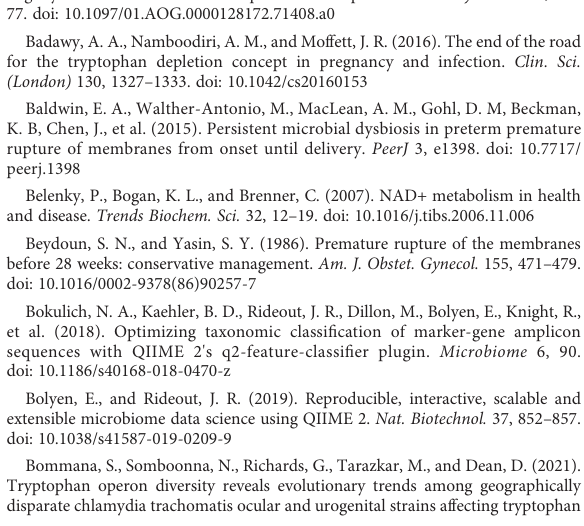
SUPPLEMENTARY FIGURE 1 Species accumulation curve. SUPPLEMENTARY FIGURE 2 Vaginal microbiota composition and percentage of dominant taxa at the genuslevel. (A) Vaginalmicrobiotacompositioninthetermdelivery group at the genus level. (B) Percentage of the dominant genera in the term delivery group. (C) Vaginal microbiota composition in the PPROM group at the genus level. (D) Percentage of the dominant genera in the PPROM group. SUPPLEMENTARY FIGURE 3 Comparisons of a - and b -diversities between the PPROM and term delivery groups. (A) Comparisons of a -diversity between groups. (B) PCoA analysis based on Jaccard distance between